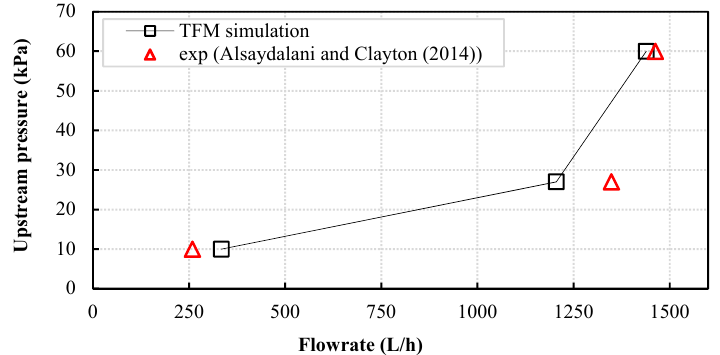
Figure 6. A comparison between the flowrates at steady-state flow from TFM simulation and the experimental results.